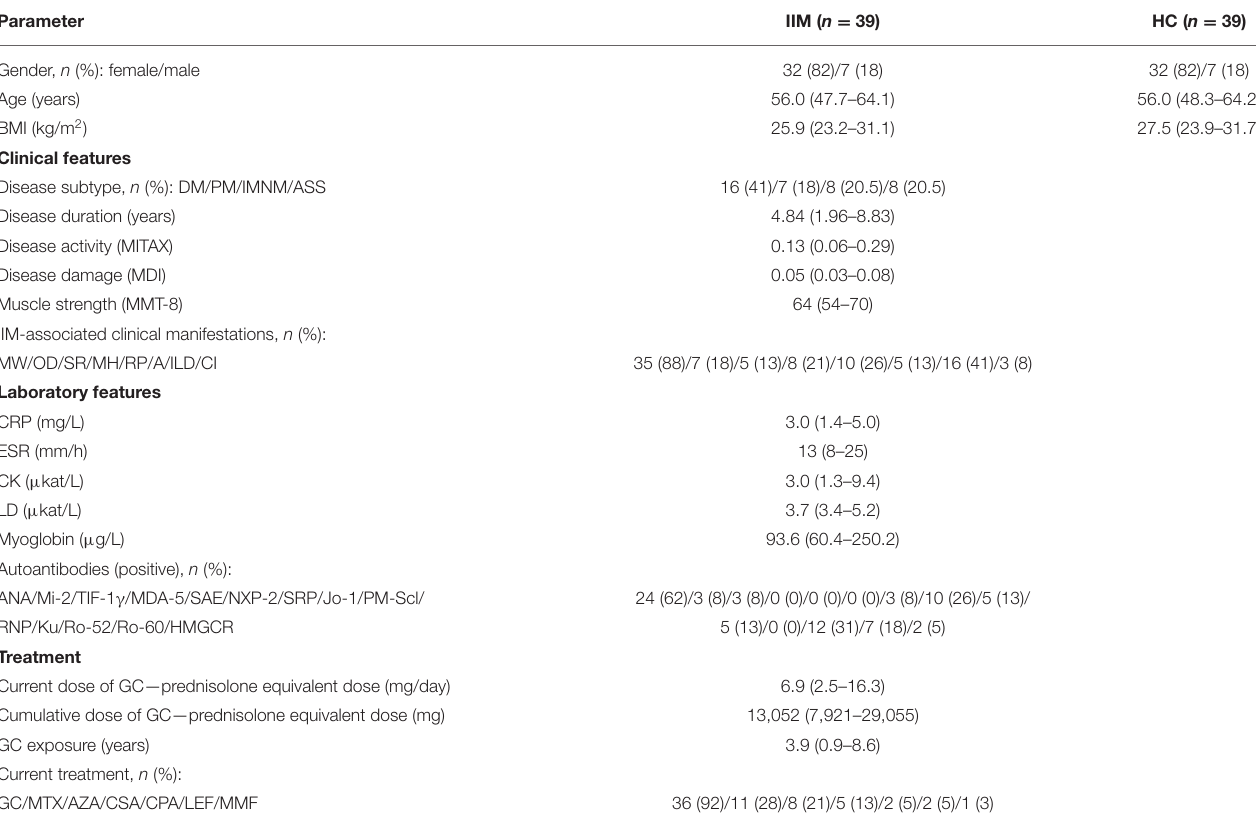
TABLE 1 | Clinical and demographic characteristics of IIM patients and healthy controls.